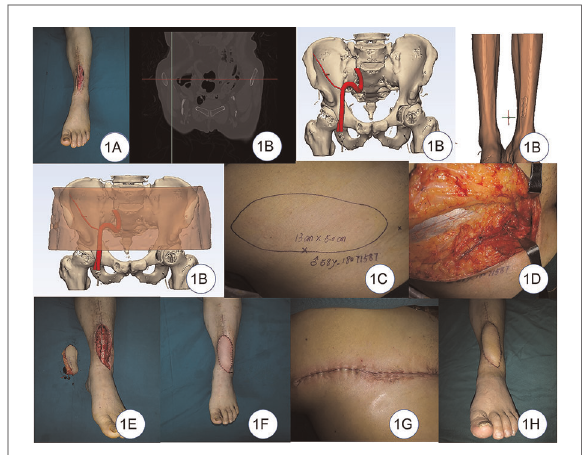
FIGURE 1 ( A ) Soft-tissue defect on the left leg. ( B ) Digital reconstruction of donor and recipient sites. ( C ) Design of the fl ap. ( D ) Location of the vessels seen intraoperatively was found to be generally consistent with the preoperative simulation design. ( E ) Flap and the defect. ( F ) Coverage of the defect. ( G ) Primary closure of the donor site. ( H ) 12-month follow-up after the